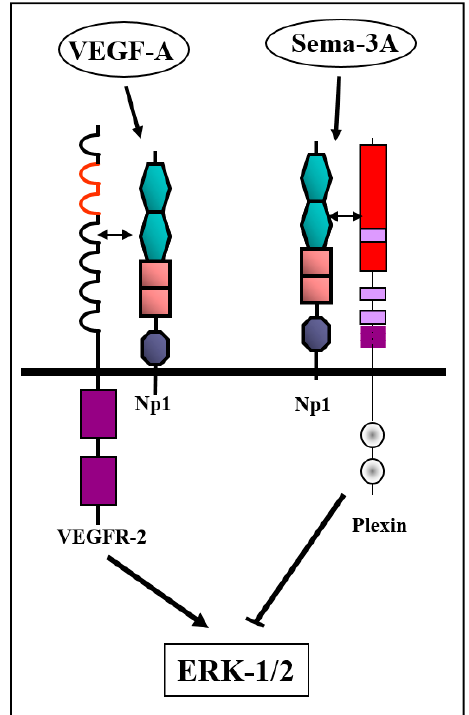
Figure 3. Sema3A inhibits VEGFR-2-mediated pro-angiogenic signaling by activation of an inhibitory intracellular signaling cascade: Sema3A binds to its neuropilin-1 receptor, thereby activating type-A plexins. This inhibits VEGF-A-induced phosphorylation of extracellular signal–regulated kinase-1/2 (ERK-1/2). However, sema3A does not compete with VEGF-A for binding to neuropilin-1 since the binding sites are completely separate. Indeed, sema3A does not inhibit VEGF-A-induced auto-phosphorylation of VEGFR-2 suggesting independently that the inhibition does not take place at the level of the VEGF-A receptors.